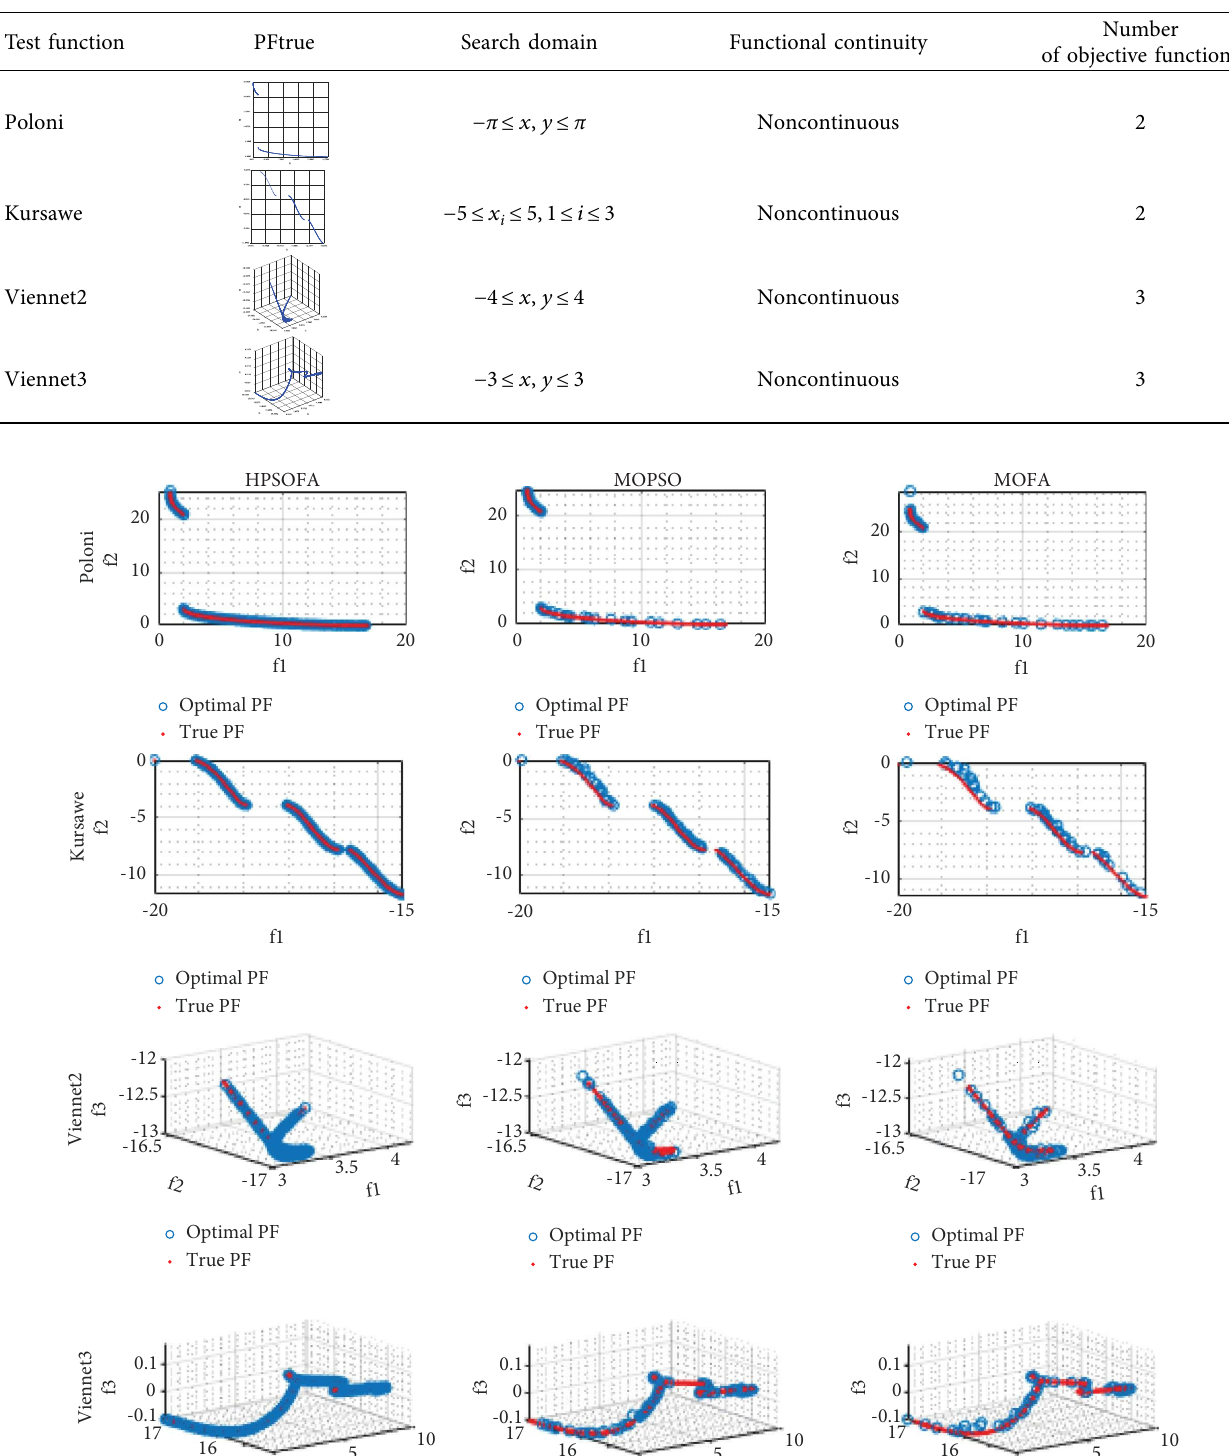
Table 1: Specifc parameters of the test function.